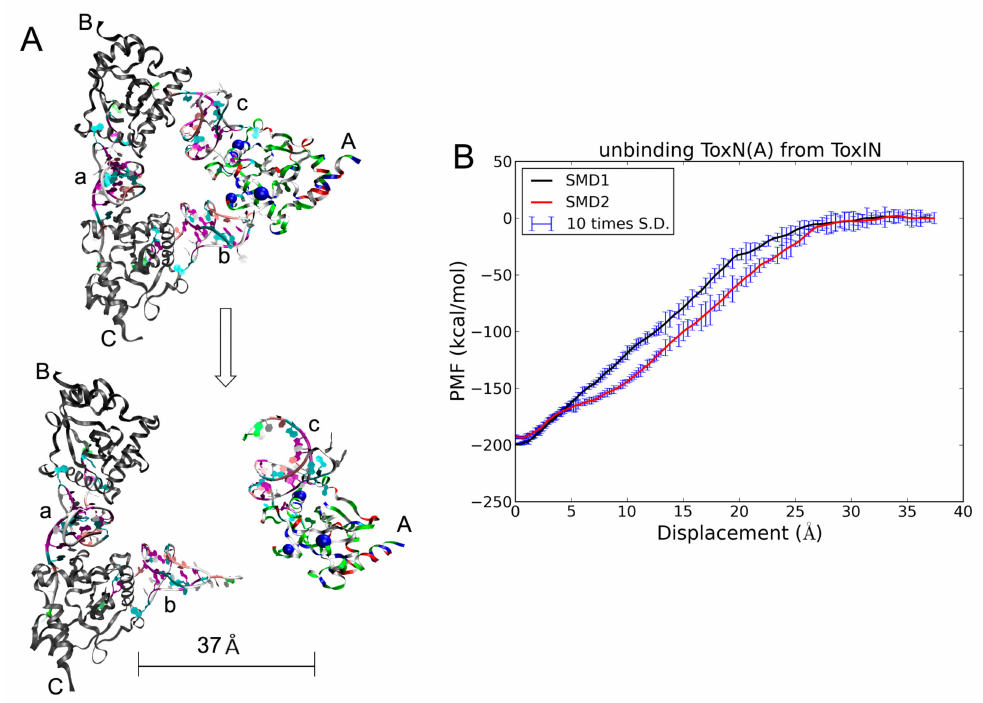
Figure 7. ( A ) The ToxIN in bound state (top) and in the unbound state (bottom). ToxN are shown in ribbons presentation. The dragged ToxN is colored by residue types. The fixed two ToxNs are colored in gray. Three ToxIs are colored by nucleotide name. The three centers are marked as blue balls. ( B ) The potential of mean force (PMF) curves of unbinding ToxN from its complex. SMD: steered molecular